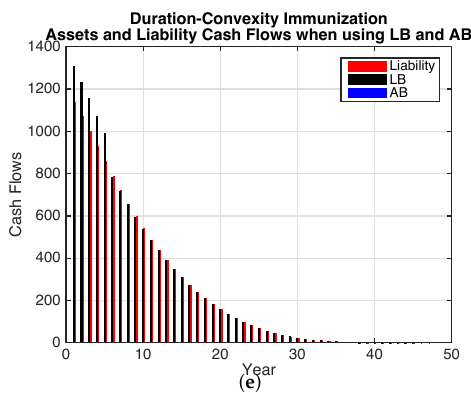
Figure 3. Asset and Liability Cash Flows—Immunization. ( a ) Only Coupon Bonds; ( b ) Only Annuity Bonds; ( c ) Only Longevity Bonds; ( d ) Coupon Bonds and Longevity Bonds; ( e ) Annuity Bonds and Longevity